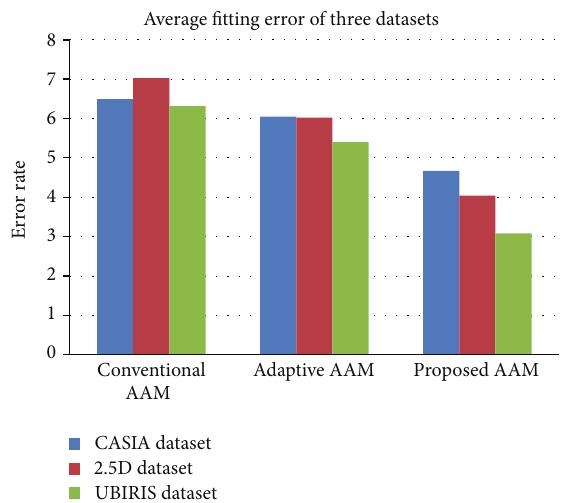
Figure 9: Fitting error average for 10 rounds taken from fitting the model in the original image by conventional AAM, adaptive AAM, and the proposed